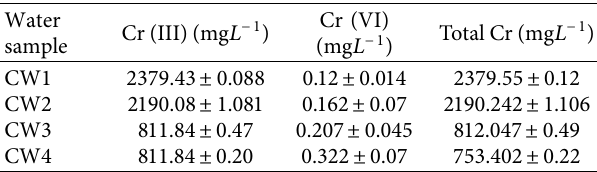
Table 1: Concentration and species of chromium in the wastewater treatment plant of Colba tannery (CW � Colba tannery water sample) [ n �